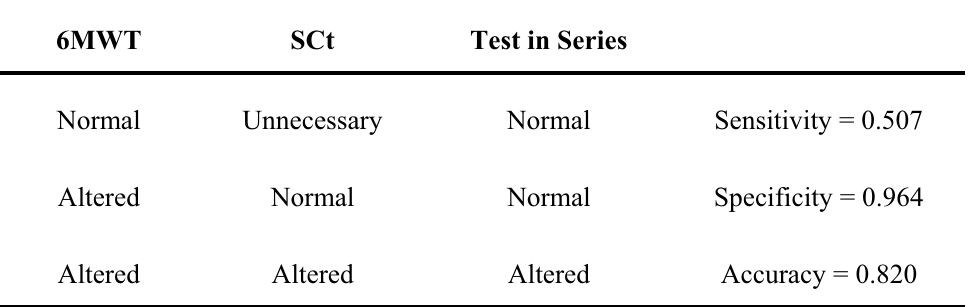
TABLE 5 - Series combination of the 6 minute walk test (6MWT) and Stair climbing time (SCt). Sensitivity, specificity,